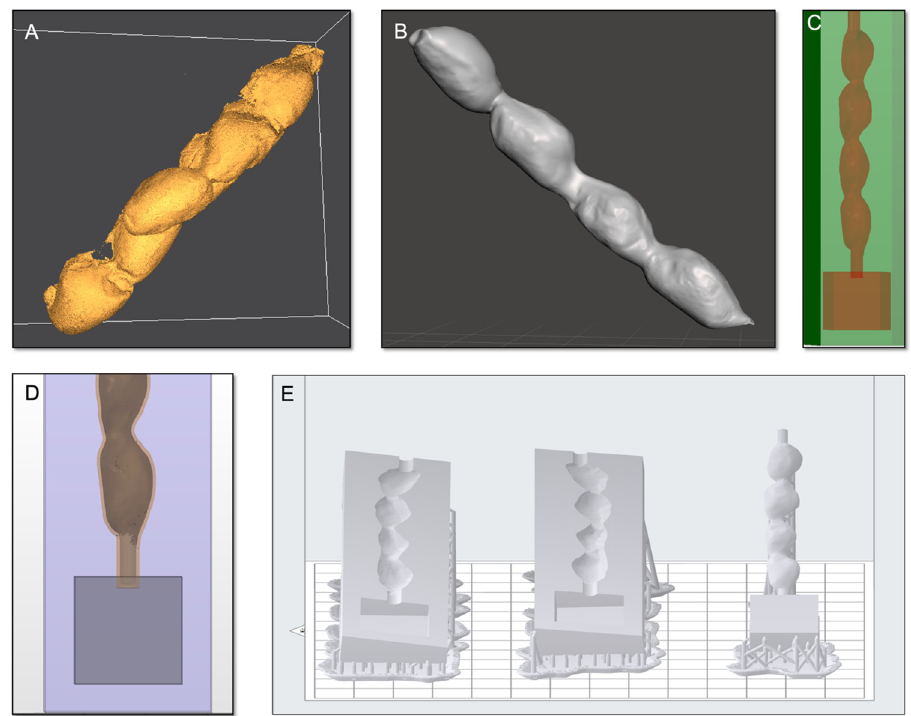
Fig 2. Steps of mold creation from the digital uterus model. The mold creation for the uterus model followed the same steps as for the embryo model, but used a three-part design to accommodate the anatomical tube shape of a single uterus horn. (A) and (B) Import of the uterus model into Netfabb and Meshmixer to clean up the model. (C) An additional uterus shape was created within the original, with an offset of 0.5 mm. (D)The offset uterus shape was equipped with cylinders at both ends and a cube at the lower end. (E) The original uterus model and the cube were subtracted from a surrounding box. The printed model consists of the two outer parts that outline the original uterus shape and the merged offset uterus model combined with the cylinders and the box to sit inside the two outer parts.